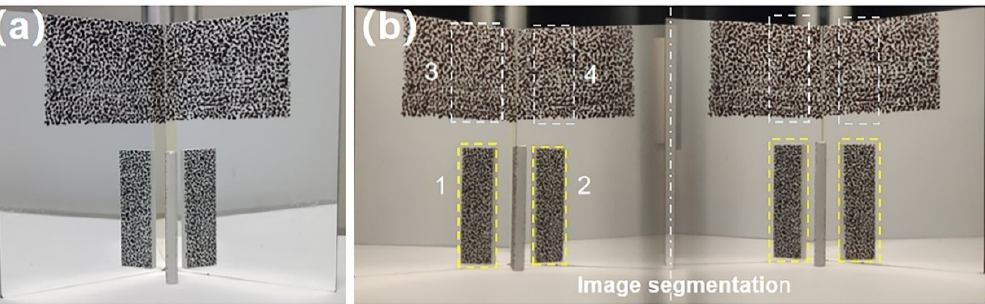
Figure 7. ( a ) Speckle pattern on the aluminum plate and two planar mirrors. ( b ) The image captured by the smartphone. The numbers indicated in ( b ) denote four ROIs selected in DIC calculation.